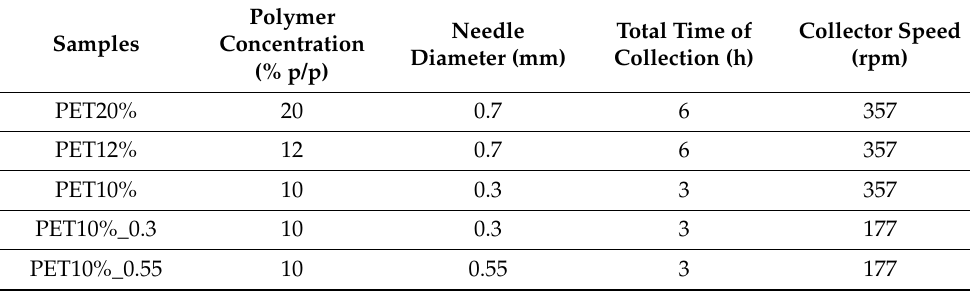
Table 1. Operating parameters for